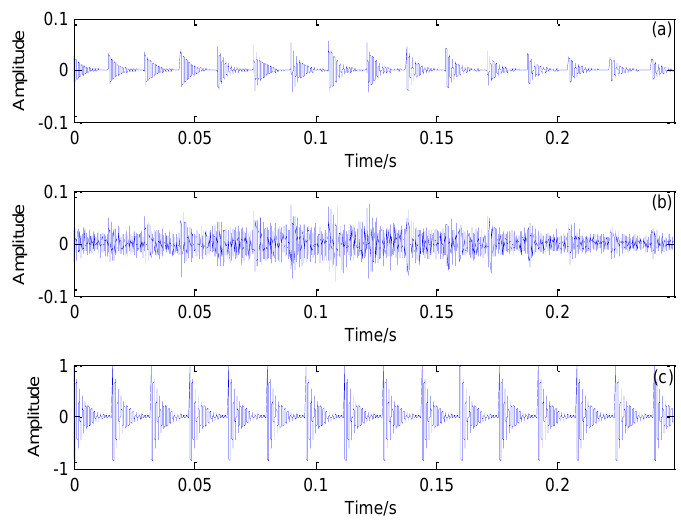
Figure 7. Results obtained by the proposed method: ( a ) the optimal Doppler transient model; ( b ) the simulated Doppler distorted signal; ( c ) the optimal periodical transient